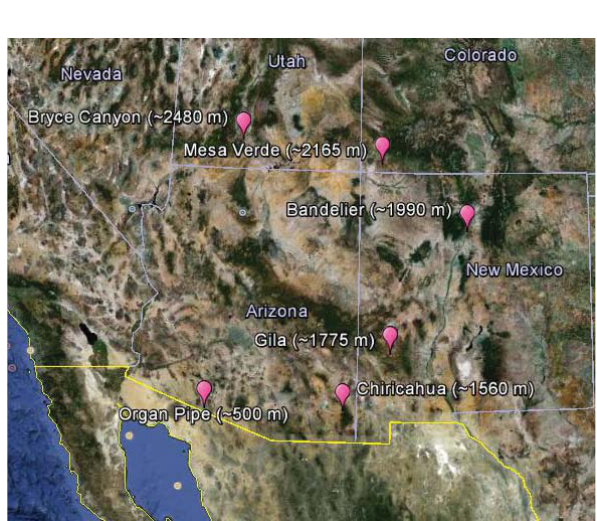
Fig. 1. Spatial map of co-located EPA IMPROVE and NADP/NTN stations used in this